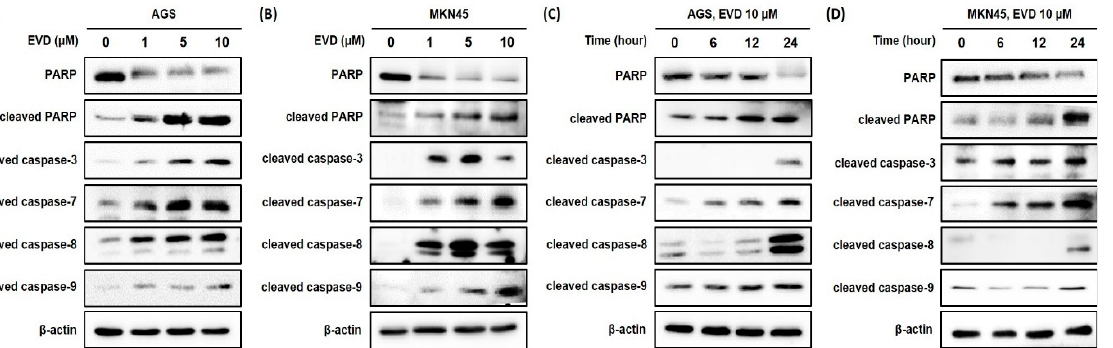
5 Figure 2. Annexin V and PI staining of AGS and MKN45 cells after evodiamine treatment. ( A ) AGS